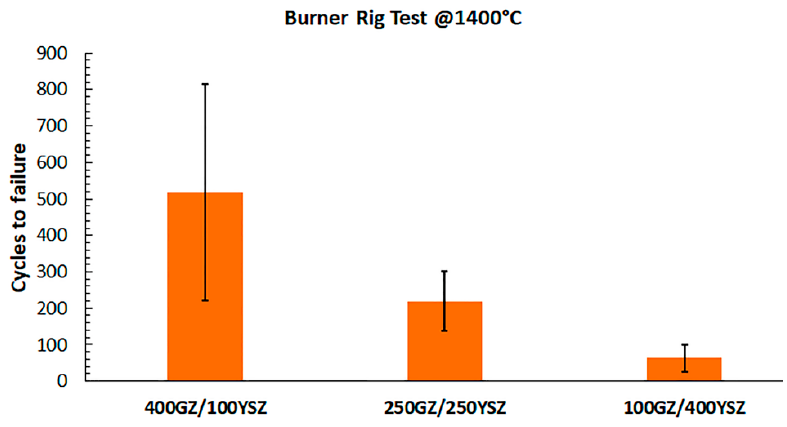
/ YSZ double-layered